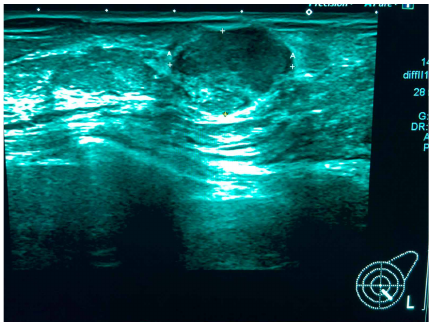
Figure 6: Ultrasound of the left breast showing a second well-defined hypoechoic solid mass, measuring 18 mm × 13 mm.